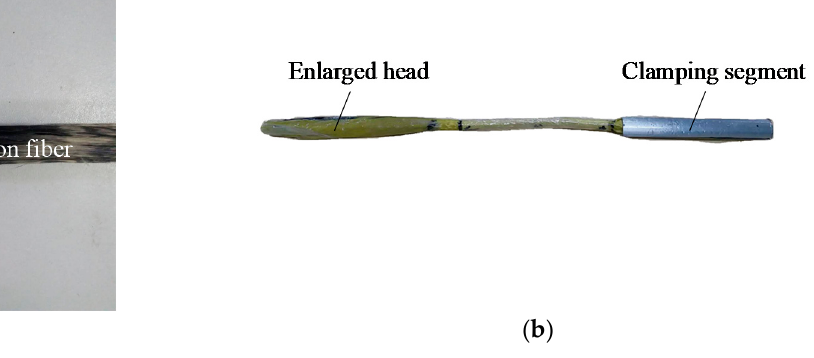
Figure 2. CFR and pretreated CFR: ( a ) CFR; ( b ) Pretreated CFR.